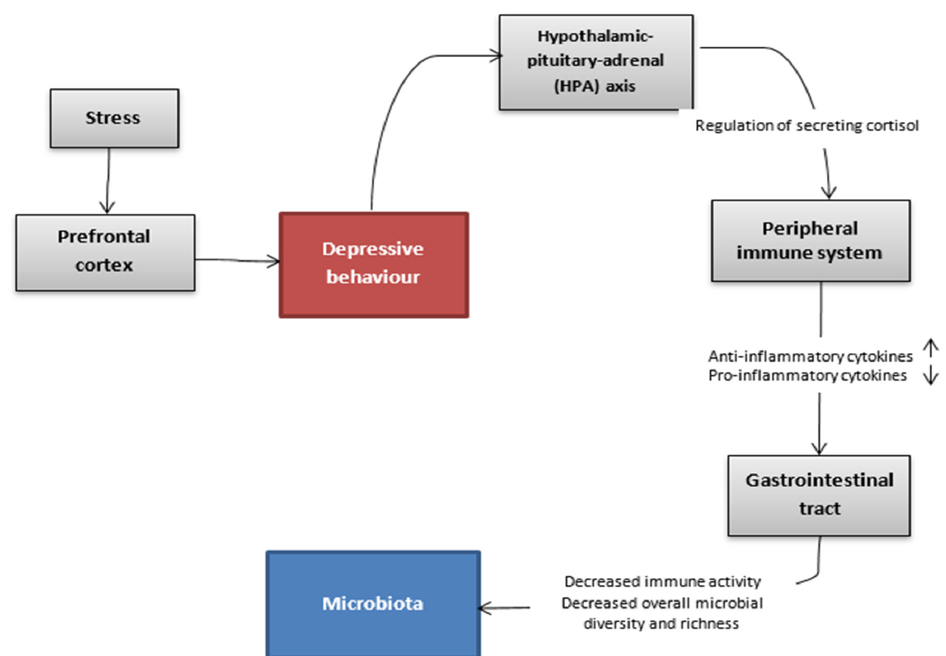
Figure 1. Hypothetic communication pathway between the brain and the gut microbiota in the depressive state. A depressed state triggers alterations in the microbiota via the hypothalamic-pituitary-adrenal axis and the immune system. This might lead to intestinal symptoms which can be further exacerbated by stress [10].